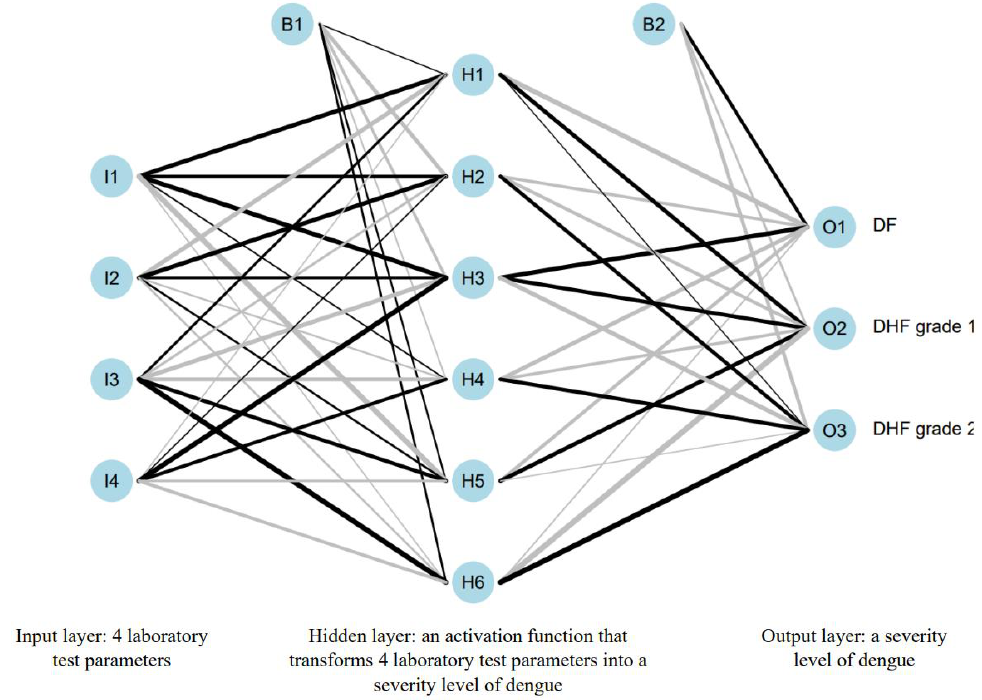
Figure 2. Artificial Neural Network (ANN) architecture of the predictive models developed using R. The activation function is frequently a bounded nondecreasing, differentiable, and nonlinear function such as the hyperbolic tangent or the logistic function [26]. We tried to used logistic and hyperbolic tangent as the activation functions. First, we developed an ANN model with logistic activation function. Then, we developed another ANN model